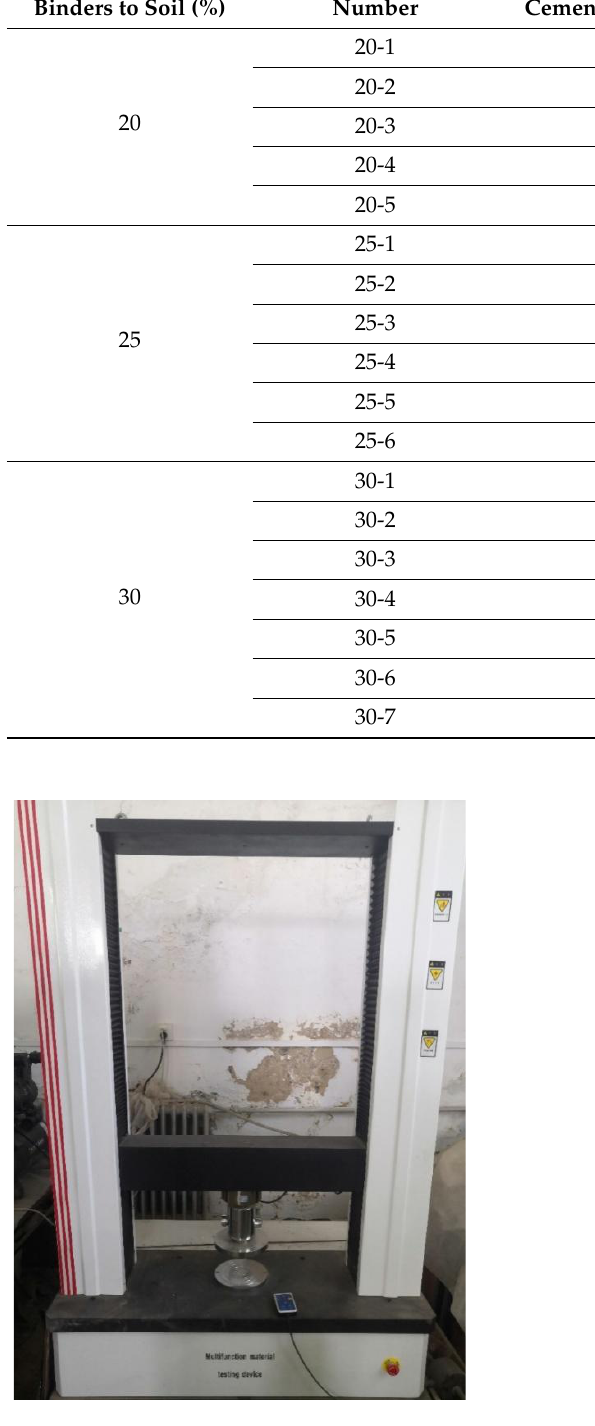
Figure 4. Universal